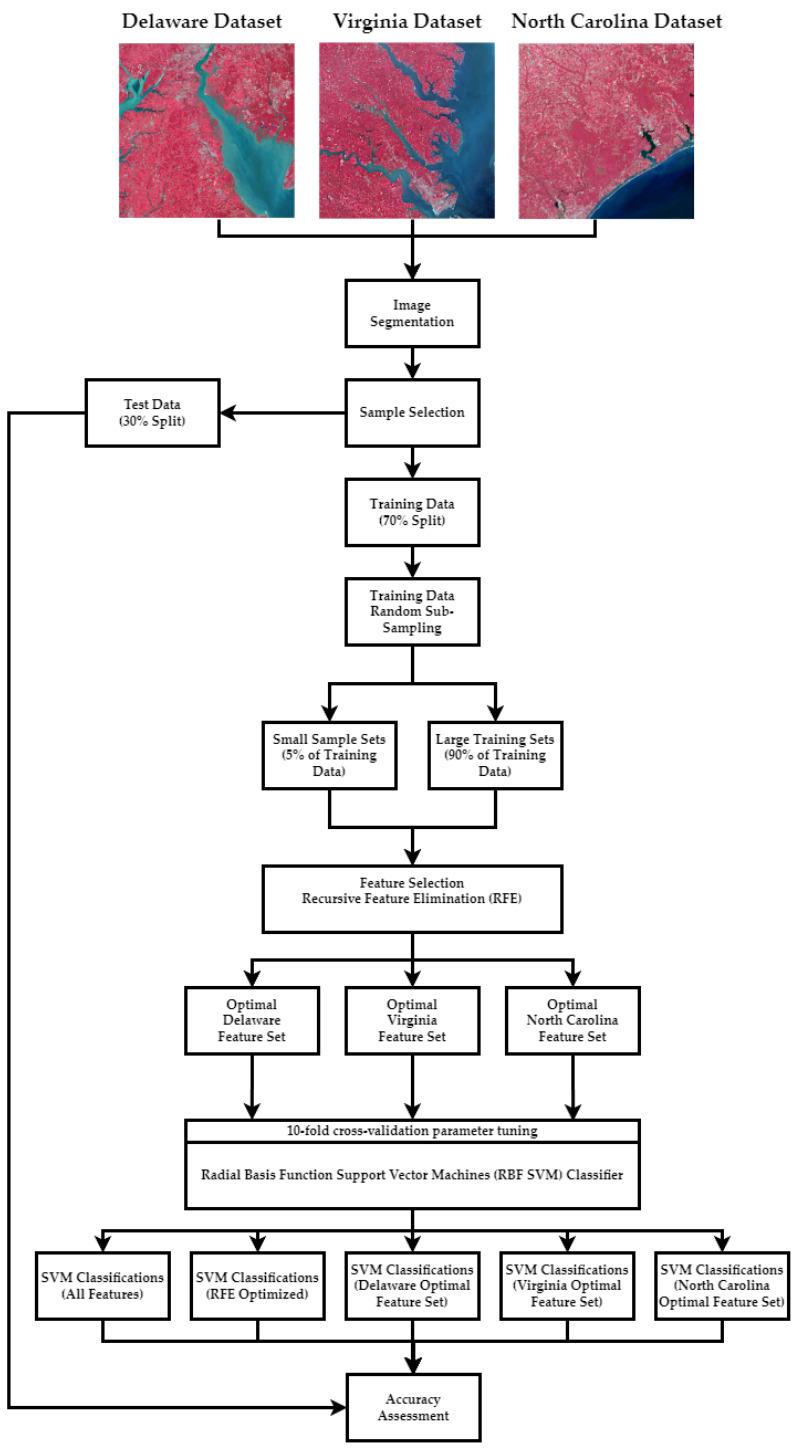
Figure 2. Overview of the experimental